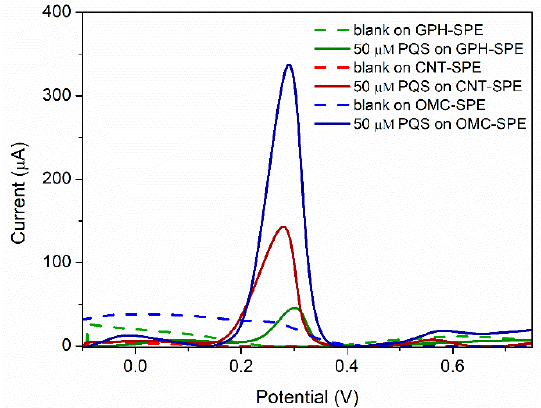
The best results were obtained on SPEs modified with carbon-based nanomaterials (Table 1). Of these, the highest peaks were obtained on the OMC-SPE (Figure 1G), followed by the CNT-SPE (Figure 1H) and the GPH-SPE (Figure 1I). These results were also confirmed by DPV (Figure 2). A drawback of the OMC-SPE is the appearance of a peak in the analysis of the blank (H 2 SO 4 0.5 M), which overlaps with the peak corresponding to PQS (Figure 2, blue). Although on CNT-SPE the peak corresponding to PQS is smaller, it does not show any peak in the blank (Figure 2, red).